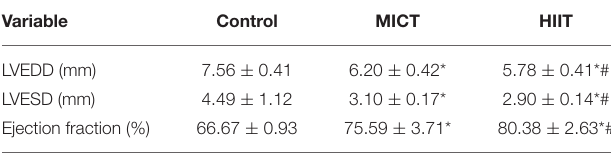
TABLE 3 | Echocardiographic changes produced by exercise in diabetic rats.